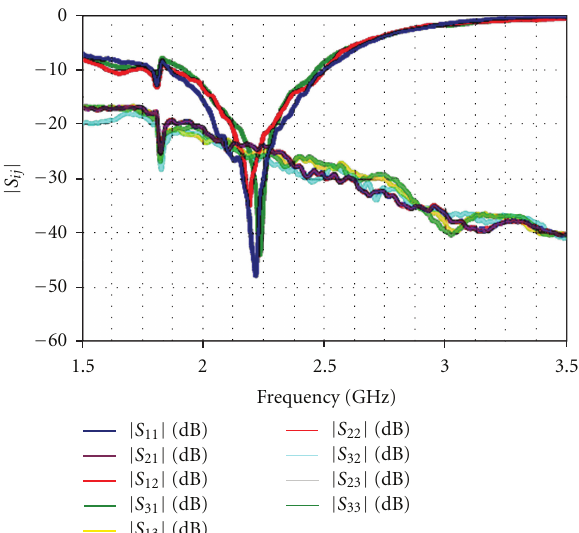
Figure 19: 3 antennas on the edges—measured S parameters.